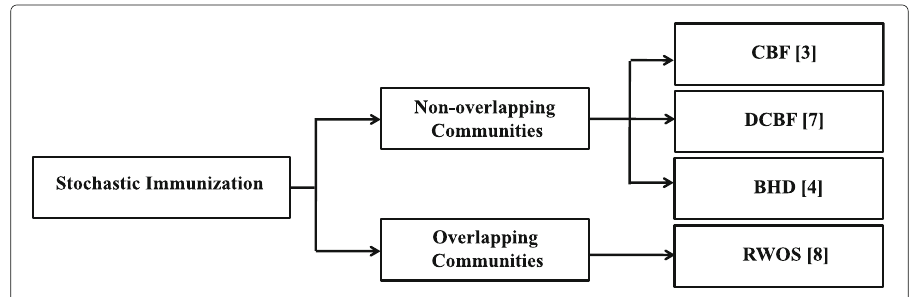
Fig. 1 Stochastic immunization